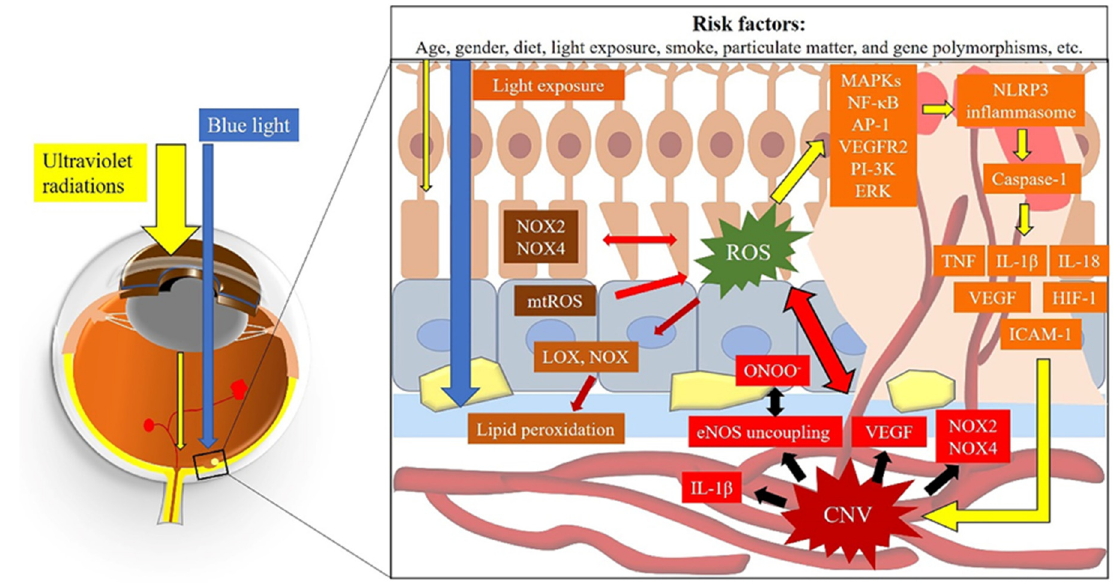
Figure 3. The interplay between ROS and CNV formation. Abbreviations: CNV: choroidal neovascularization; ROS: reactive oxygen species; mtROS: mitochondrial ROS; NOX: nicotinamide adenine dinucleotide phosphate oxidase; LOX: lysyl oxidase; eNOS: endothelial nitric oxide synthases; ONOO − : peroxynitrite; MAPKs: mitogen-activated protein kinases; NF- κ B: nuclear factor- κ B; VEGF: vascular endothelial growth factor; VEGFR2: vascular endothelial growth factor receptor 2; ERK: extracellular signal-regulated kinase; PI-3K: phosphoinositol 3-kinase; AP-1: activator protein 1; NLRP3: nod-like receptor family pyrin domain containing 3; TNF: tumor necrosis factor; IL-1 β : interleukin-1 β ; IL-18: interleukin-18; HIF-1: hypoxia-inducible factor 1; ICAM-1: intercellular adhesion molecule-1.